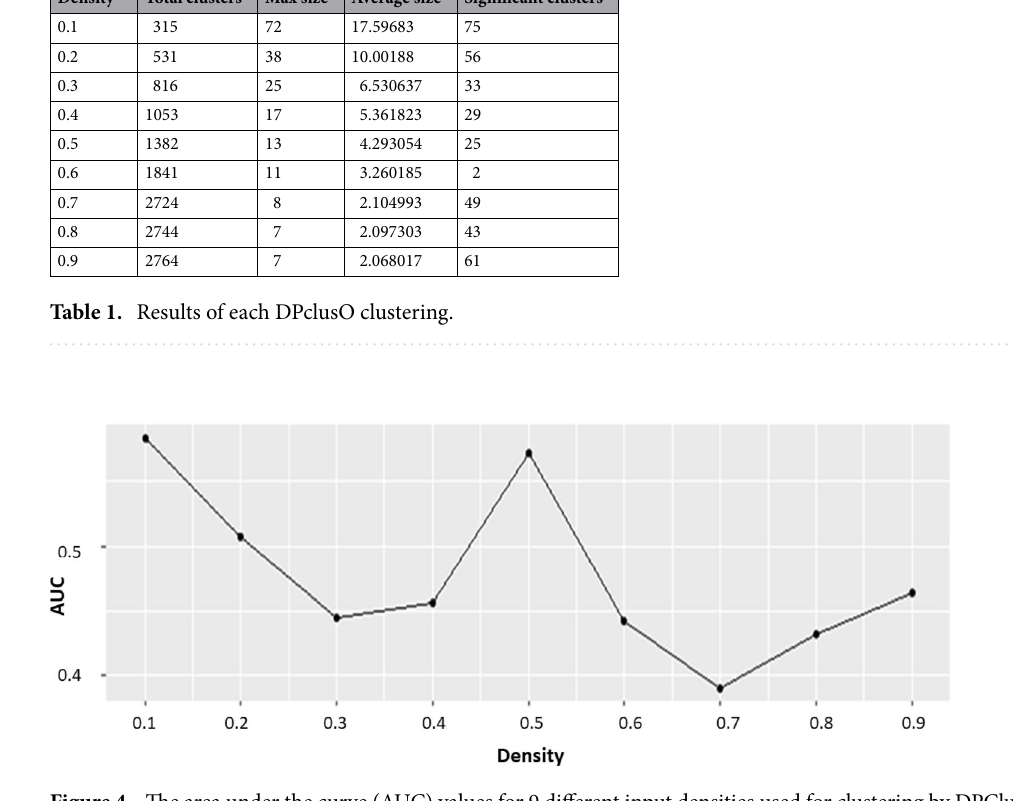
Figure 4. The area under the curve (AUC) values for 9 different input densities used for clustering by